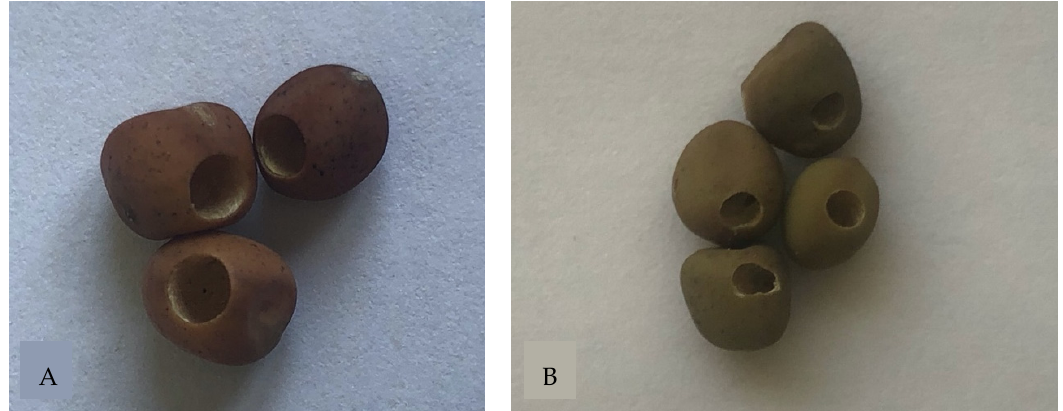
Figure 3. Seed damage holes of pea weevil in AWP 442 ( A ) and AWP 449 ( B ) under field conditions. Accessions (ACP 13, ACP 14 and ACP 20) of P. sativum subsp. sativum were free from neoplasm